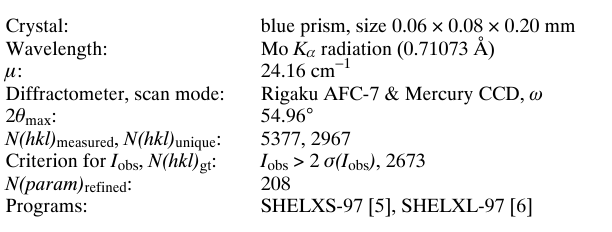
Table 1. D a t a collection a nd h a ndling.